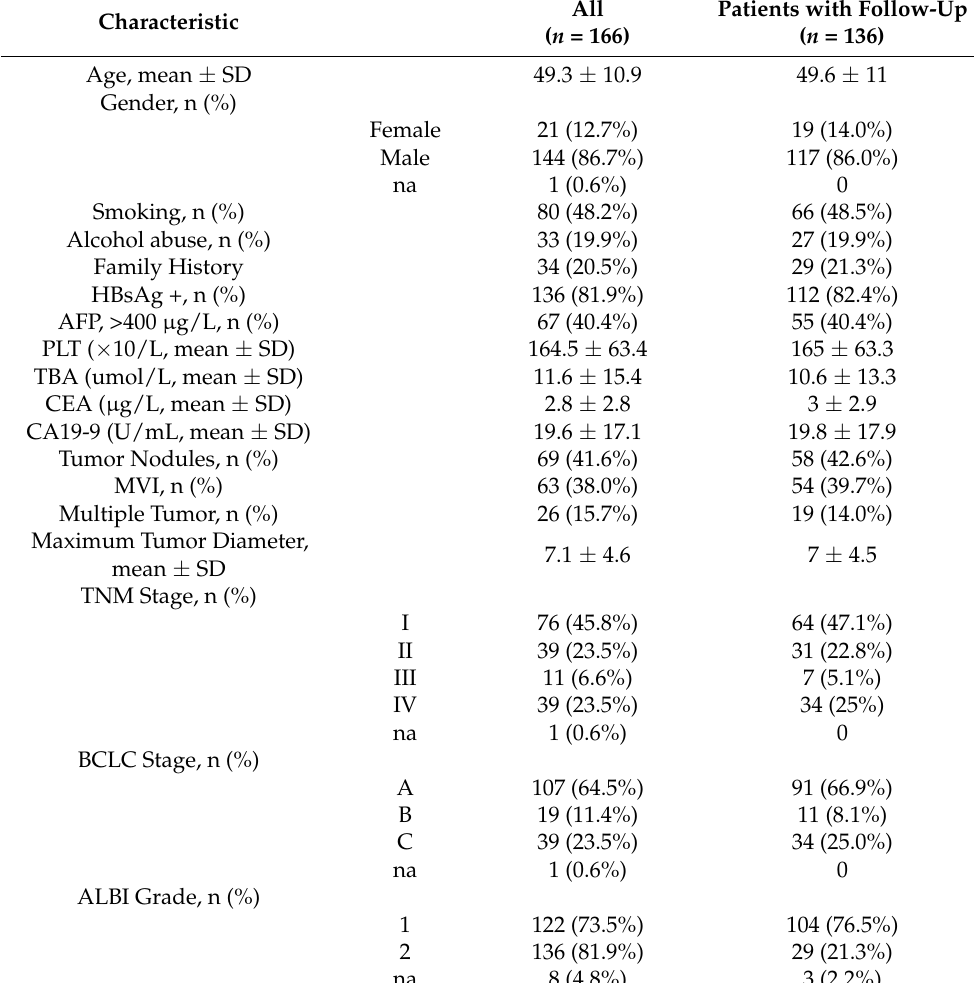
Table 1. Clinical and pathological features of HCC